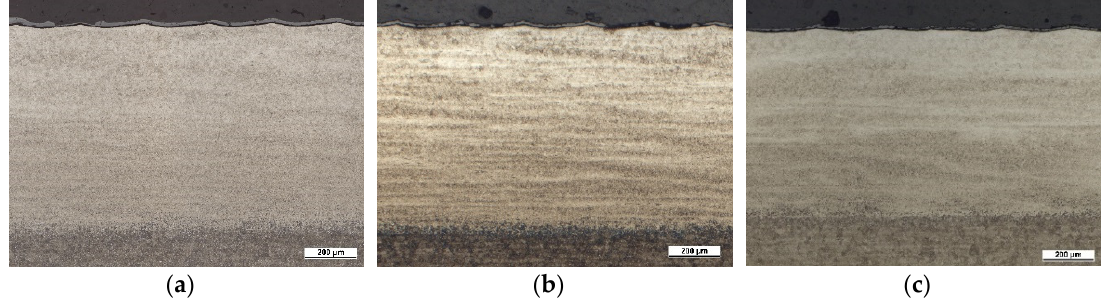
Figure 10. Microstructure of specimens after polishing and etching. The specimens were hardened with an optimized intensity profile at feed of 300 ( a ), 400 ( b ) and 500 mm/min ( c ).